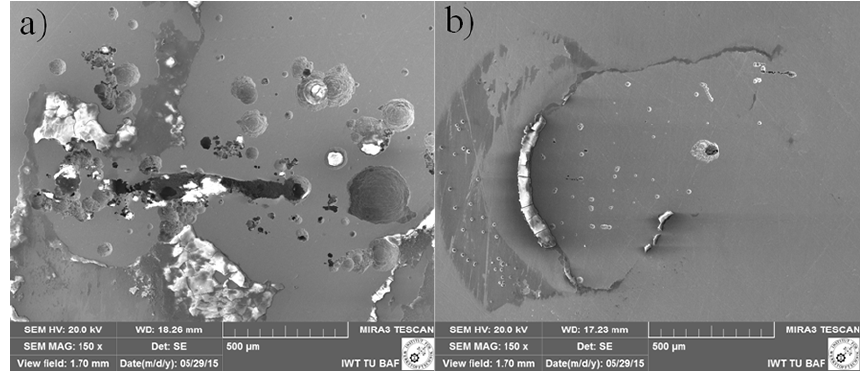
Figure 15. Pits and salt particles on the surface of the sample of the 316L (a) and 317L (b) steels after removing the corrosion products of the pressurized test.